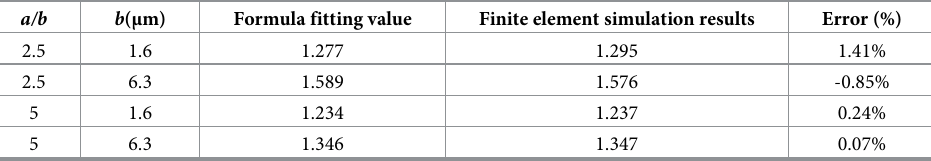
Table 1. The fitting error of single micro-notch empirical